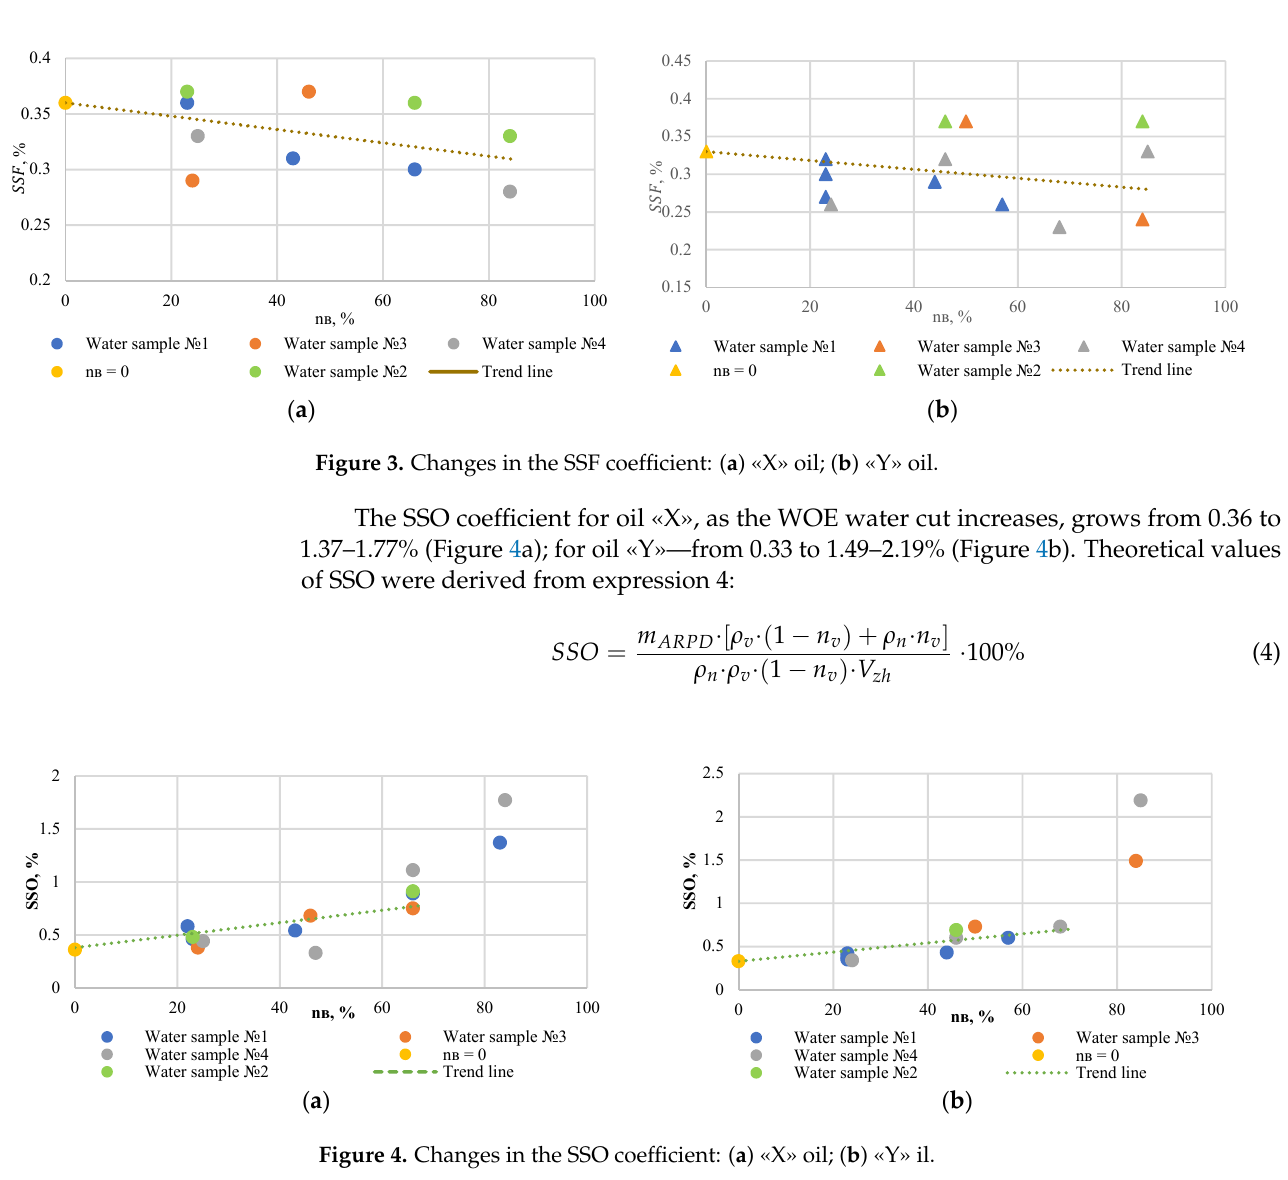
At the maximum water cut, the coefficient of SSF for oil «X» is 0.28% (Figure 3a); for oil «Y»—0.24% (Figure 3b).